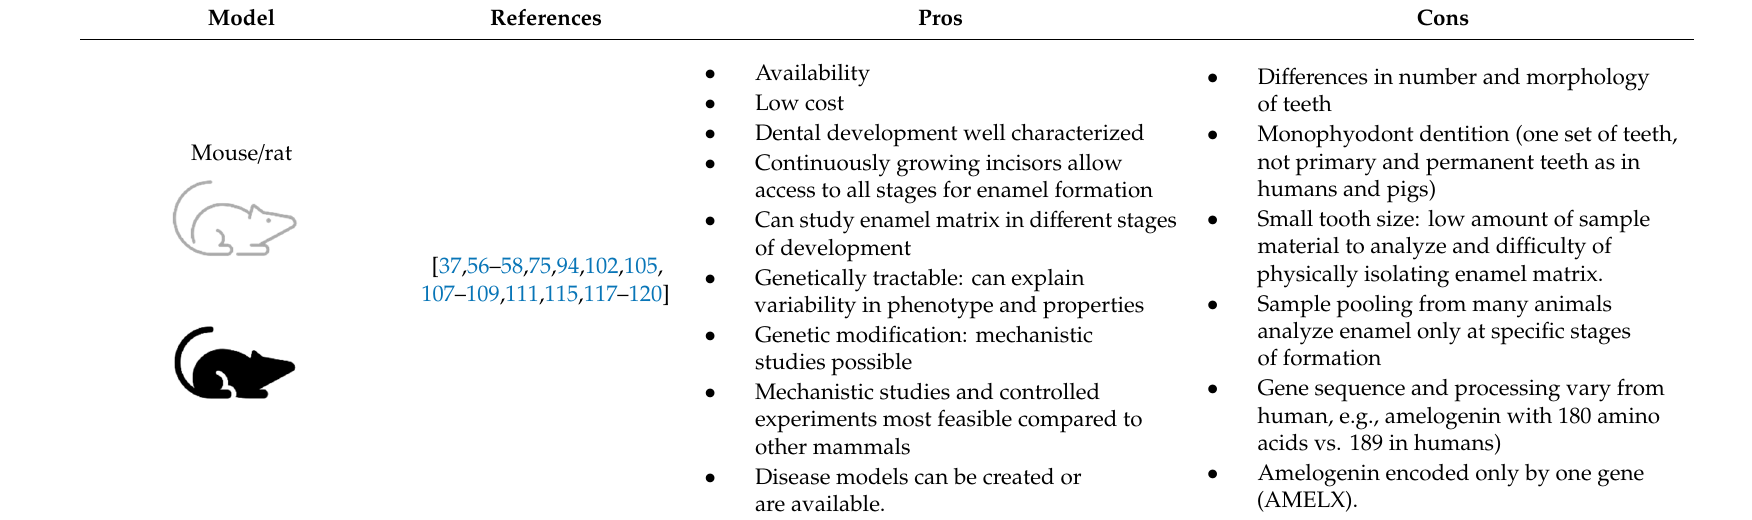
Figure 5. Schematic of potential mechanism of post-translational modifications and secretion of enamel proteins during the course of enamel formation. (1) Post-translational modifications of enamel proteins occur with the ameloblast. These modifications are used as a signal to be secreted, cleavage during the secretory stage and degraded during the maturation stage. (2) Some of the enamel proteins generated with the ameloblast lack post-translational modification and they are secreted via non- classical pathways. These proteins would be less or not degraded during the mineralization process. (3) Alternative to pathway 1, de-phosphorylation to account for the presence of